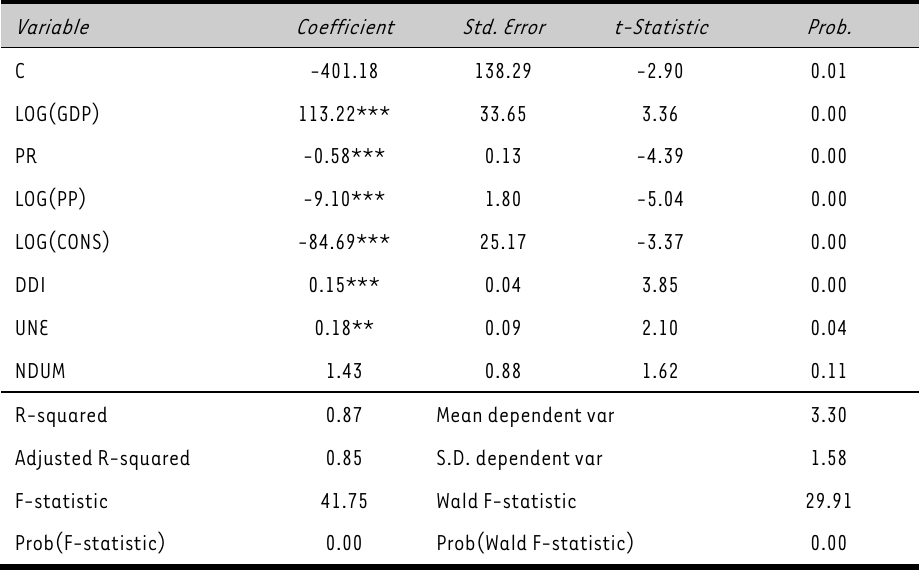
TABLE 4: Results after Newey-West test (excluding inflation